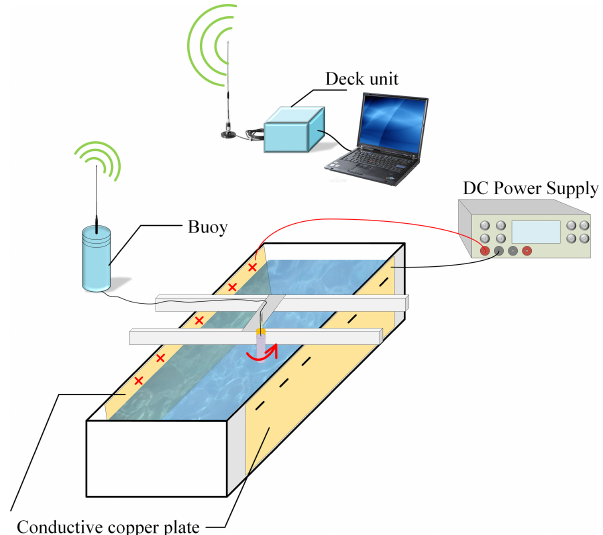
Figure 14. Schematic diagram of the XCP experimental setup.